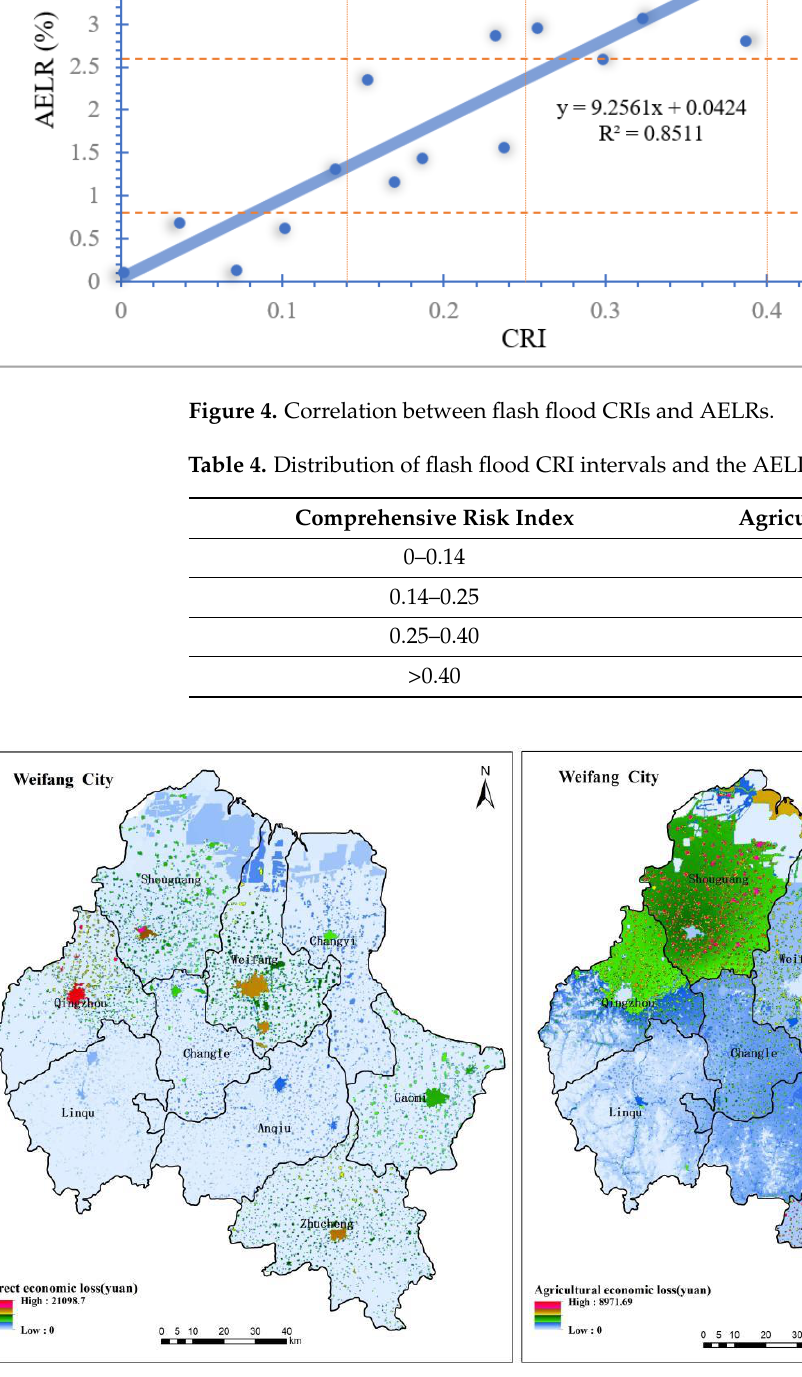
Figure 5. Spatial distribution of economic losses (10 August 2007). Table 5. Error analysis of flood loss estimation on the flash-flood process in Weifang on 10 August 2007.